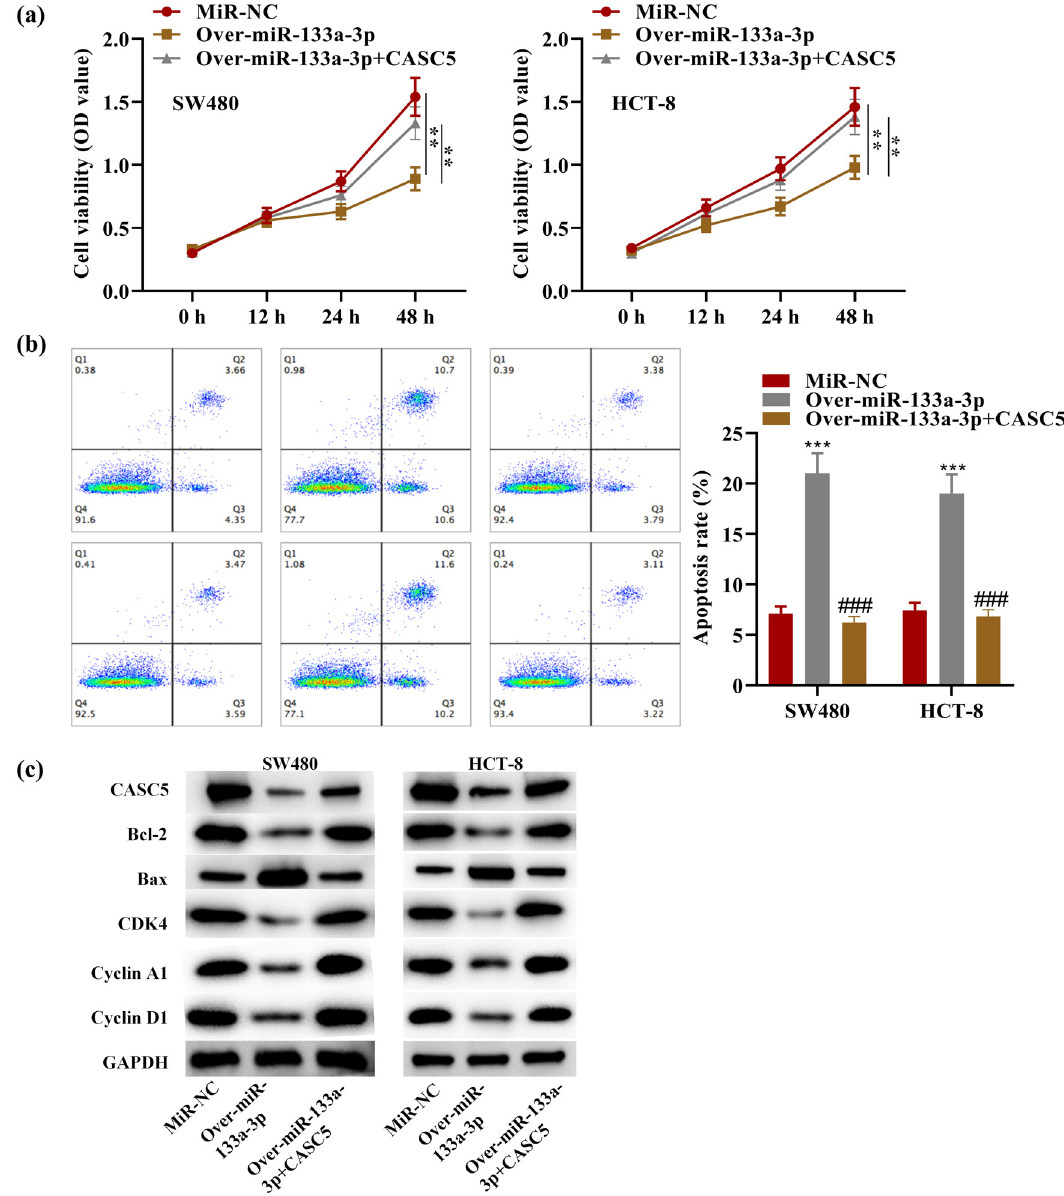
Figure 3: ( a ) OD value of 450 nm in SW480 and HCT - 8 at 0, 12, 24, and 48 h. ( b ) Flow cytometry results and apoptosis rate of SW480 - and HCT - 8 transfected with miR - NC, over - miR - 133a - 3p, and over - miR - 133a - 3p + CASC5. ( c ) Western blot results of CASC5, Bcl - 2, Bax, CDK4, Cyclin A1, Cyclin D1, and GAPDH in SW480 and HCT - 8 transfected with miR - NC, over - miR - 133a - 3p, and over - miR - 133a - 3p + CASC5. ** P < 0.01, *** P < 0.001 compared with the miR - NC group; ### P < 0.001 compared with the over - miR - 133a - 3p